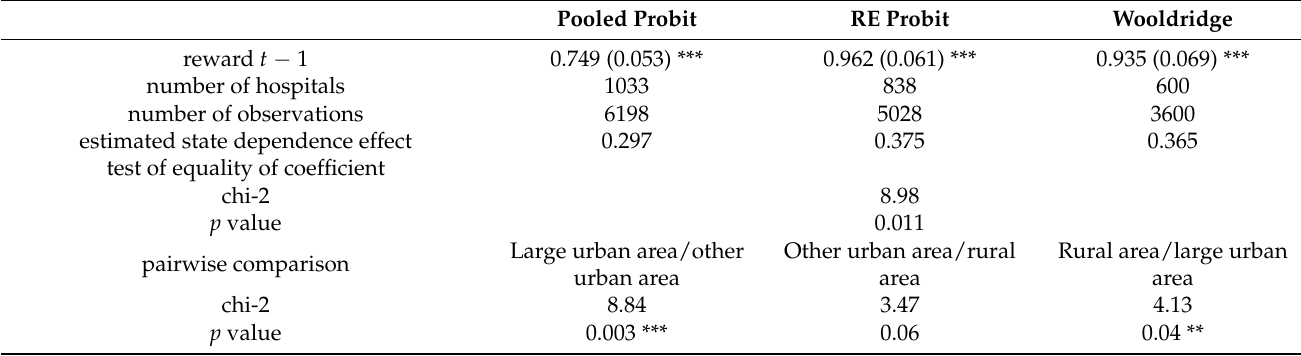
Table 8. Results of model estimates of state dependency. Pooled Probit RE Probit